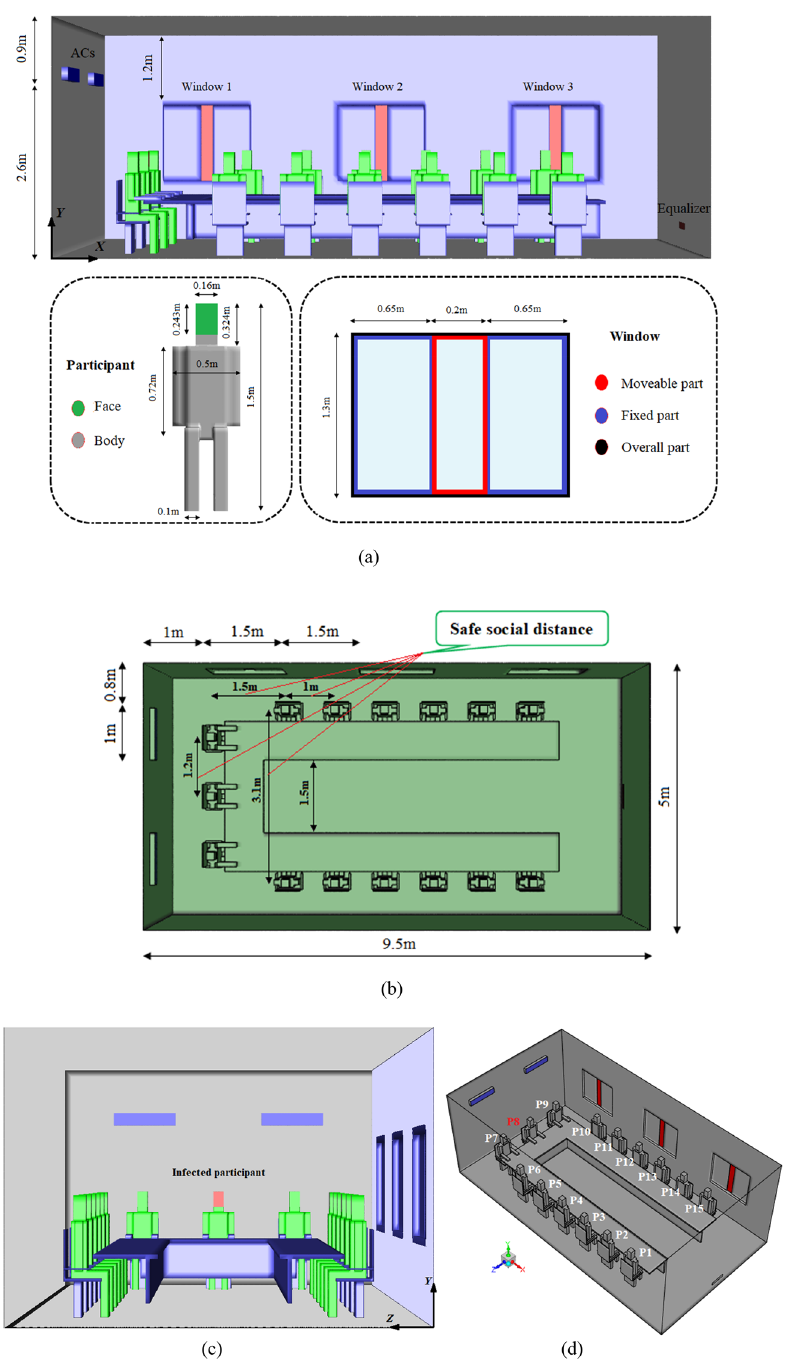
Figure 2. Schematics of the meeting room and sitting arrangement. ( a ) A side view of the computational domain and seated participants with a presentation of the different parts of the window; ( b ) dimensions of the room with a safe social distance (≥ 1 m); ( c ) front view of the computational domain and location of the infected participant (P8); ( d ) layout and naming of seated participants (the participants in the room are labeled P1 through